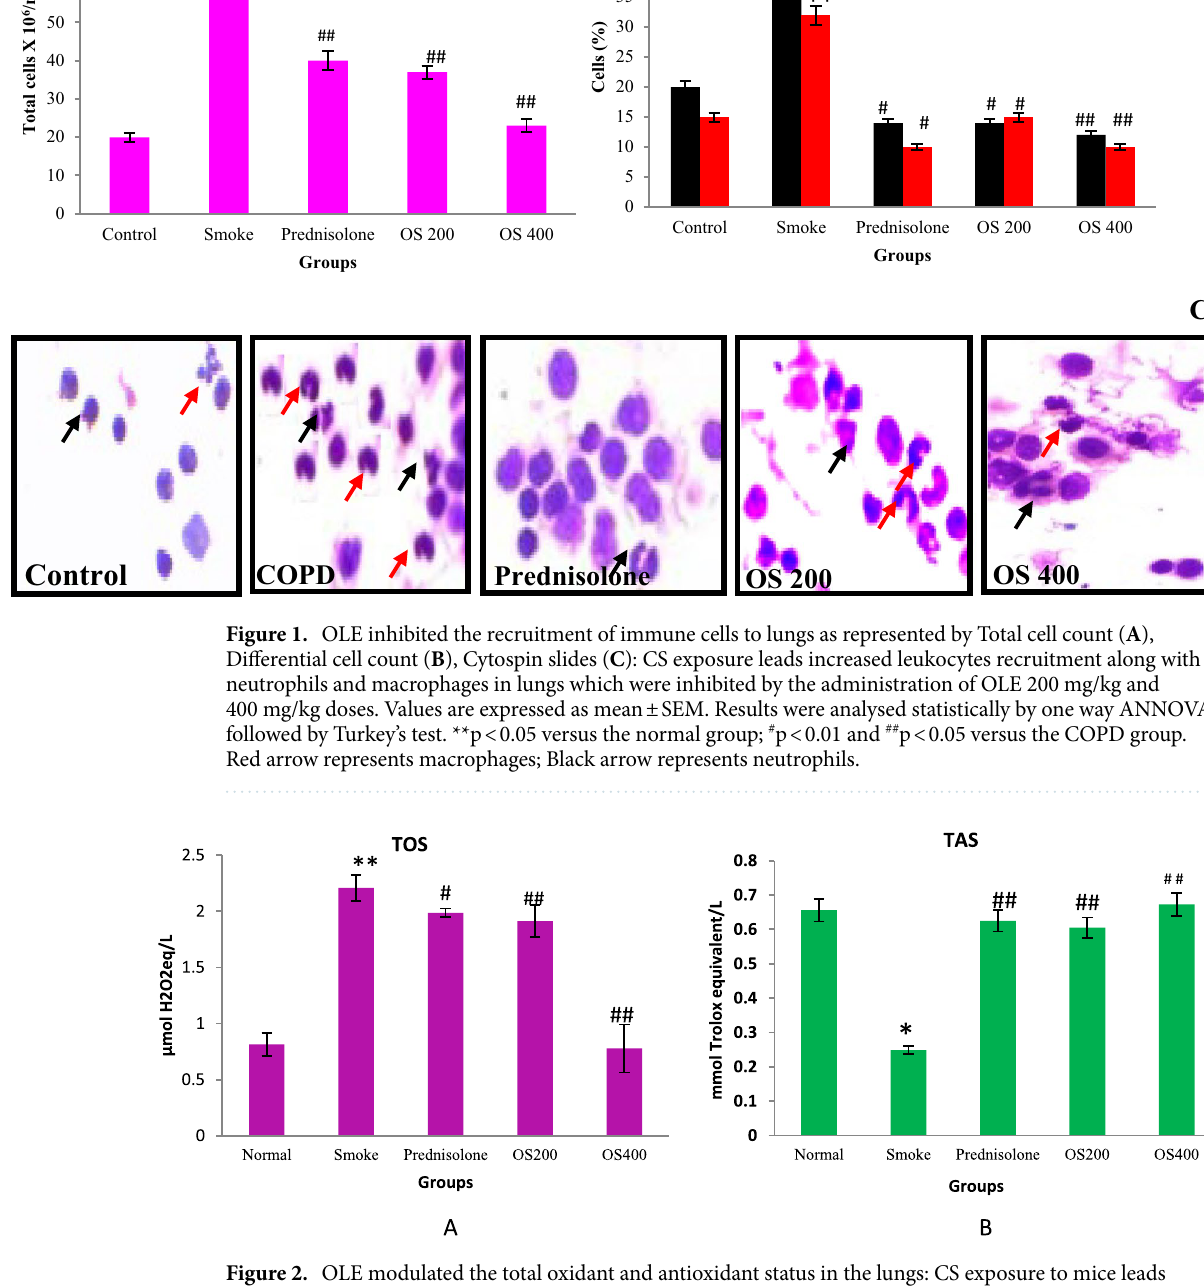
Figure 2. OLE modulated the total oxidant and antioxidant status in the lungs: CS exposure to mice leads an increased total oxidant ( A ) and decreased antioxidant status ( B ) in the lungs which were reversed by the administration of OLE with 200 mg/kg and 400 mg/kg. Values are expressed as mean ± SEM. Results were analysed statistically by one way ANNOVA followed by Turkey’s test. *p < 0.01 and **p < 0.05 versus the normal group; # p < 0.01 and ## p < 0.05 versus the COPD